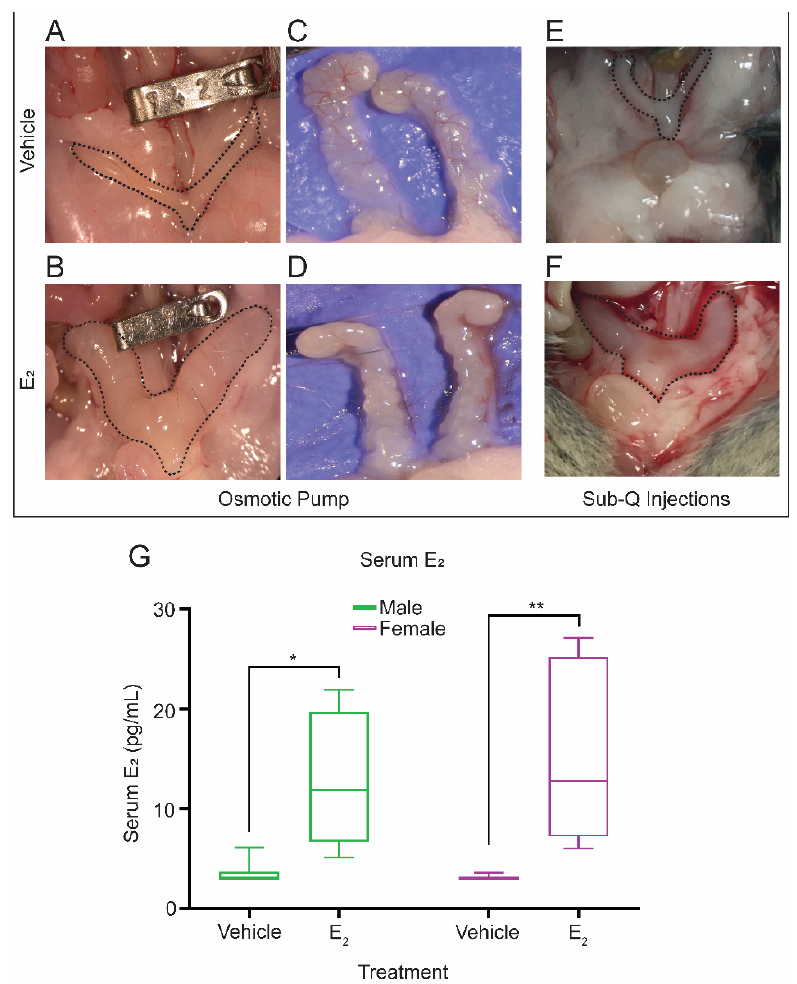
Figure A1. Qualitative and quantitative assessment of E 2 delivery. ( A – F ) Representative photographs of the uterine horns and seminal vesicles of gonadectomized female and male mice administered either vehicle or vehicle/E 2 . The left two columns depict qualitative changes to uterine horns ( A , B ) and seminal vesicles ( C , D ) with E 2 -replacement delivered via an osmotic pump, while the right column depicts qualitative changes to the female uterine horns ( E , F ) when E 2 -replacement is administered via subcutaneous injections. ( G ) Quantitative assessment of serum E 2 levels collected from the trunk blood of vehicle-treated males ( n = 8) and females ( n = 7) and E 2 -treated males ( n = 8) and females ( n = 8) when treatments were administered via an osmotic pump. Serum estradiol levels were compared using a 2-way ANOVA (treatment × biological sex) followed by Tukey’s post-hoc test. Box plots: minimum value, 1st quartile, median, 3rd quartile, maximum value; * p < 0.05, ** p < 0.01. Table A1. F-scores for main effects of treatment and biological sex for the 2-way and 3-way ANOVAs.